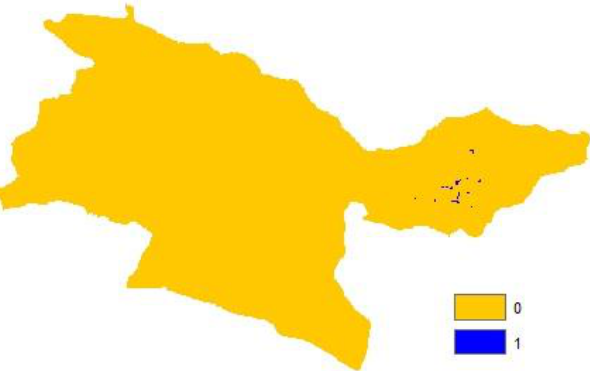
Figure 6. Best suitable locations for solar farm and wind